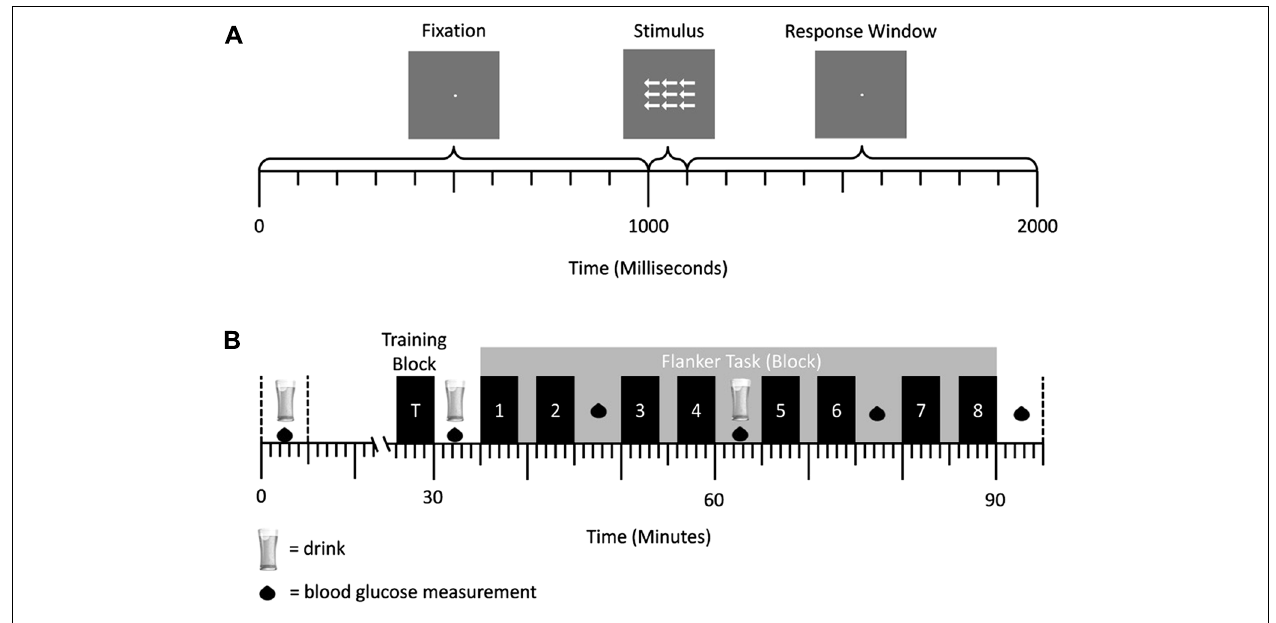
representation of a testing session. Glucose/placebo drinks were administered at 30 min intervals, while BGC measurements were taken every 15 min. The eight blocks of the flanker task were performed after administration of the second drink. They are represented by the numbered